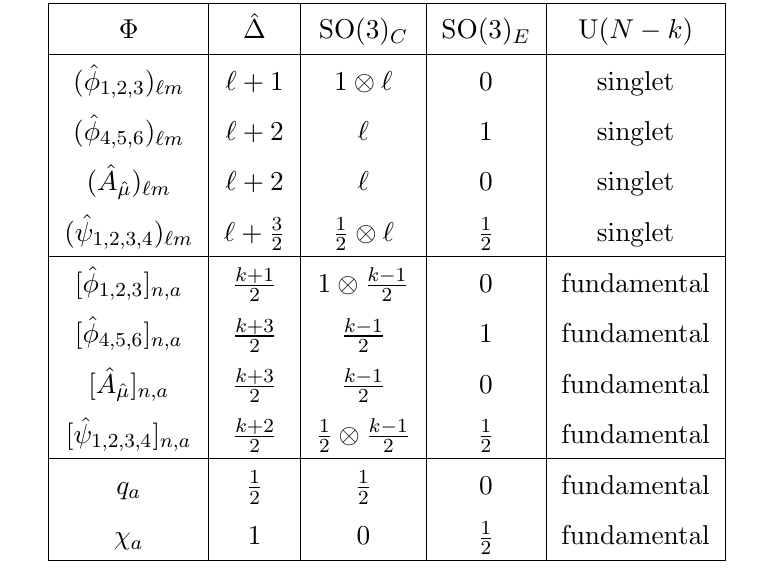
Table 3 . Boundary